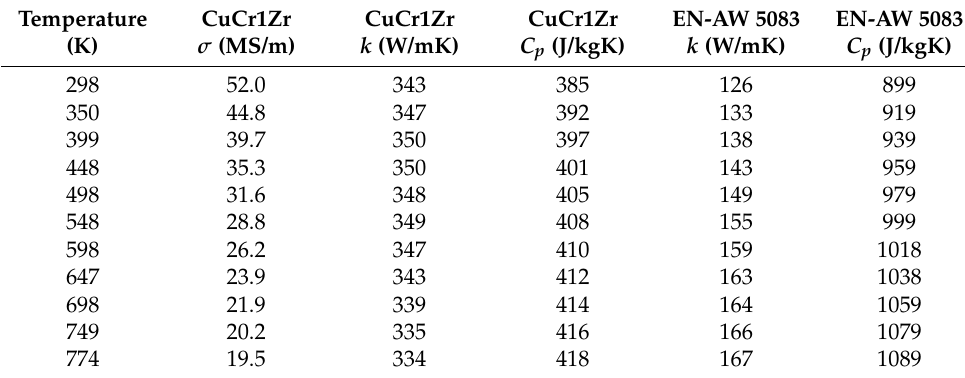
Table 1. Electrical and thermal properties for CuCr1Zr and EN AW-5083.